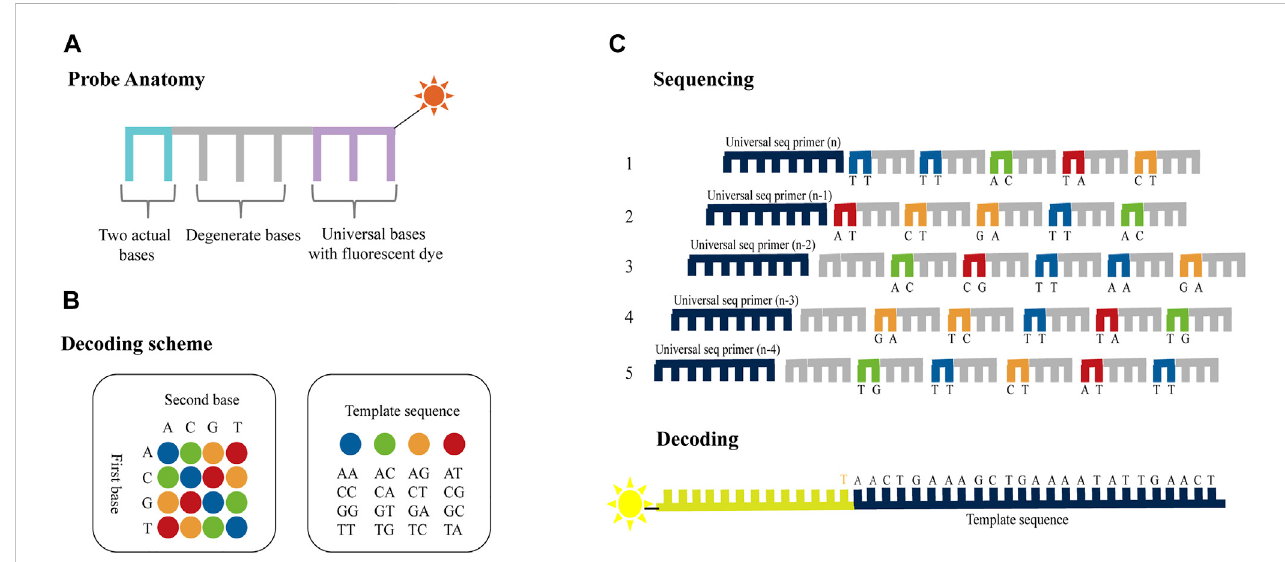
FIGURE 3 Schematics of dual-base sequencing based on SBL. (A) Two-base-encoded probe consists of two actual bases followed by three degenerate bases and three universal bases which are attached to a fl uorescent label. (B) The decoding scheme of SOLiD platform. The four different colored probes represent 16basepairs,respectively. (C) TheprobesareligatedwiththeprimersusingaDNAligaseandthe fl uorescentsignalisdetectedtoidentifythe fi rsttwobasesin eachfragment.Thentheterminaldegeneratebasesandthe fl uorescentlabelarecleavedafterdetectiontherebypreparingthesystemforanotherround ofligation. Theprocessisrepeateduntiltwo outofevery fi vebases areidenti fi ed. Thetemplate sequence information can bededuced through fi verounds of ligation reactions using ladder primers sets.